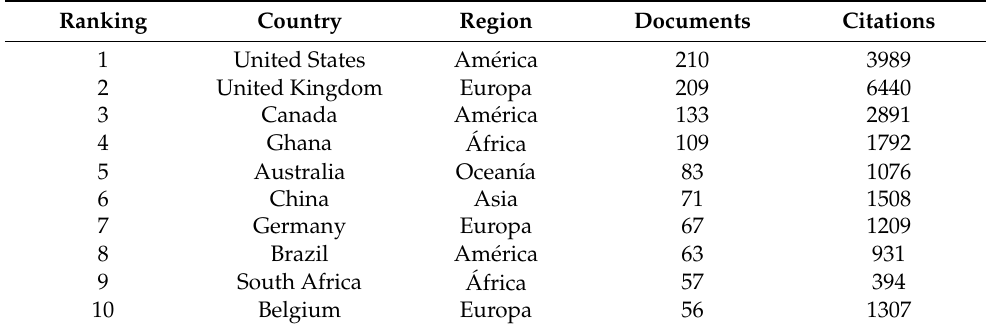
Table 1. Top 10 countries by the number of